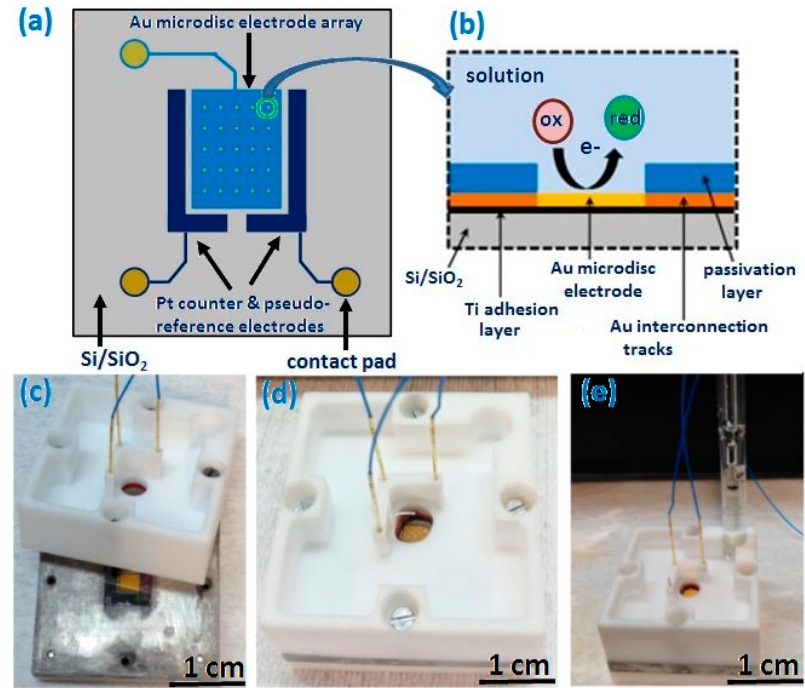
Figure 1. ( a ) Schematic representation of the chip design comprising gold microdisc array working electrodes, platinum counter and pseudo-reference electrodes; micron scale gold interconnection tracks and contact pads; ( b ) cross-sectional representation of a gold microdisc electrode on a chip; ( c ) photograph of a fully fabricated chip mounted in the aluminium base of the custom-designed cell (the cell’s upper PTFE housing includes spring-loaded probes enabling electrical contact between on-chip electrodes and a potentiostat); ( d , e ) photographs of a fully assembled chip using on-chip platinum pseudo-reference electrode and an external reference electrode, respectively.